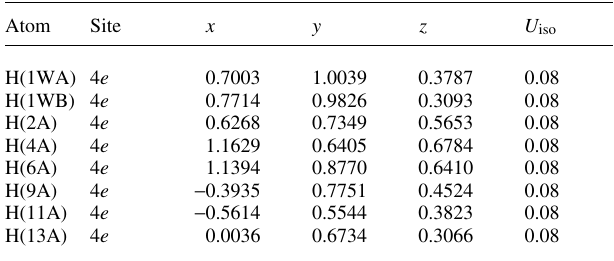
Table 2. Atomic coordinates and displacement parameters (in Å 2 ) . Table 1. Data collection and